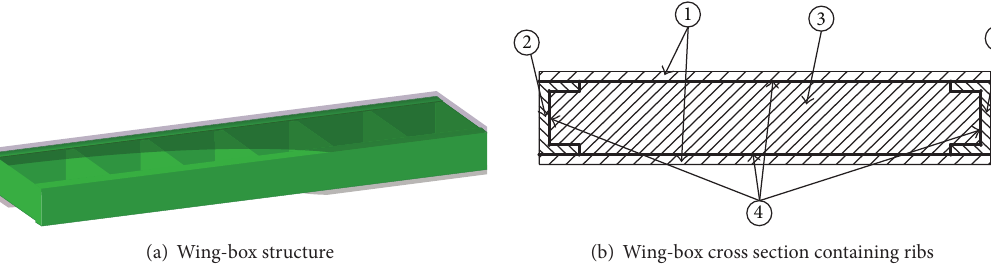
Figure 2: Schematic diagram of composite wing-box. A Skin. B C beam. C Rib plate. D Bonding